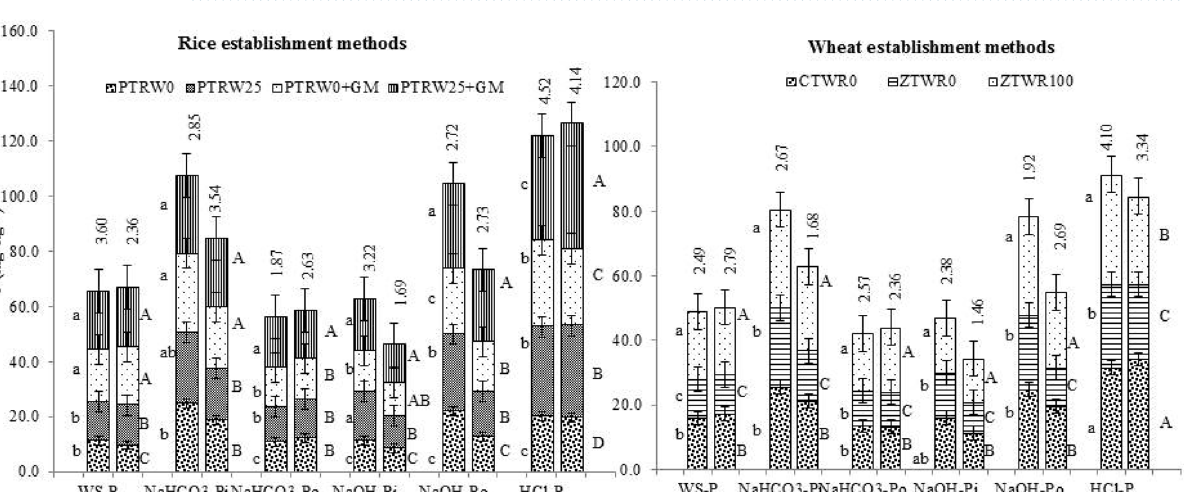
Figure 2. Effect of tillage, green manure and residue management practices on phosphorus fractions in micro- aggregate (1–2 mm) and macro-aggregate (> 2 mm) after five years of rice–wheat cropping system. PTR W0 - puddled transplanted rice with no wheat straw, PTR W25 -puddled transplanted rice with 25% anchored wheat straw retained, GM-Green manure, CTW R0 -conventional tillage wheat with rice straw removed, ZTW R0 -zero tillage wheat with rice straw removed, ZTW R100 -ZTW with rice straw retained as surface mulch. Vertical bars are the standard errors of the mean ( p < 0.05 ). First and second stacked bars indicate 1–2 mm and > 2 mm, respectively. The values above the vertical bars represent least significant difference